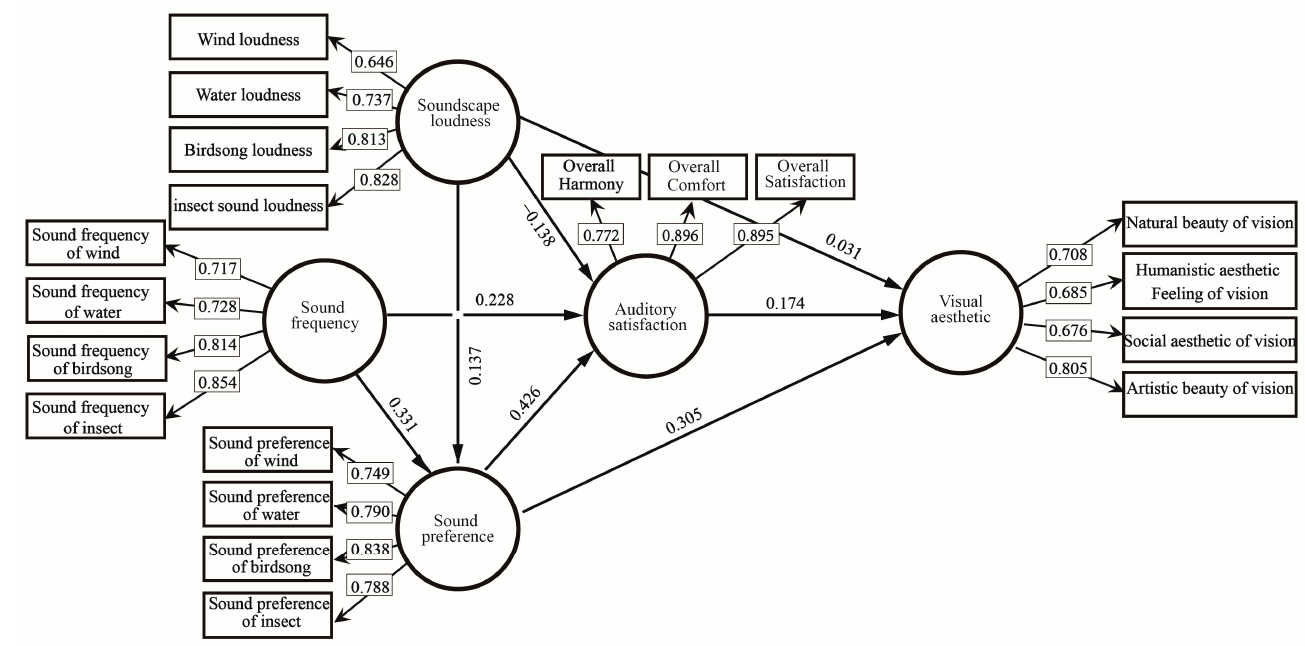
Figure 5. Soundscape auditory perception impact model.